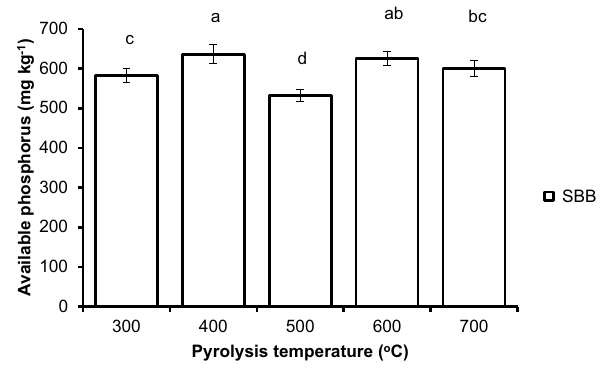
Fig. 2 Available phosphorus (Olsen P) concentration of sugarcane bagasse biochar